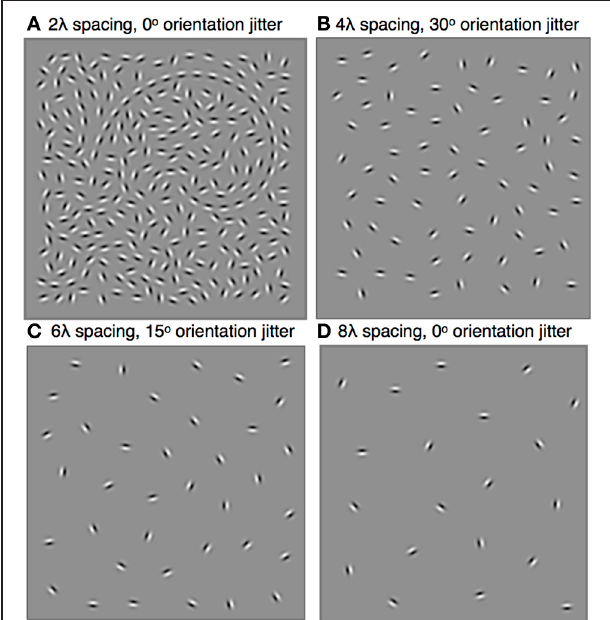
FIGURE 1 | Stimuli were spiral-shaped contours sampled with Gabors ( λ = 0 . 30 ◦ , σ = 0 . 11 ◦ ) and embedded in a field of randomly oriented distracter Gabors. The shape and size of the spiral, which could be clockwise or counter-clockwise, remained constant throughout the experiment, but its global orientation and position varied randomly across trials. Subjects reported the global orientation of the spiral by indicating the location of its tail. The minimum inter-element distance varied across blocks and ranged from 0.6 ◦ to 2.4 ◦ , or 2 λ to 8 λ . Within each block, contour element orientations were jittered by the addition of local orientation jitter ranging from 0 ◦ to 60 ◦ . Four stimulus examples are shown: (A) 2 λ distance, 0 ◦ jitter, tail is on the left; (B) 4 λ distance, 30 ◦ jitter, tail is on the right; (C) 6 λ spacing, 15 ◦ jitter, tail is at the top; (D) 8 λ spacing, 0 ◦ jitter, tail is at the